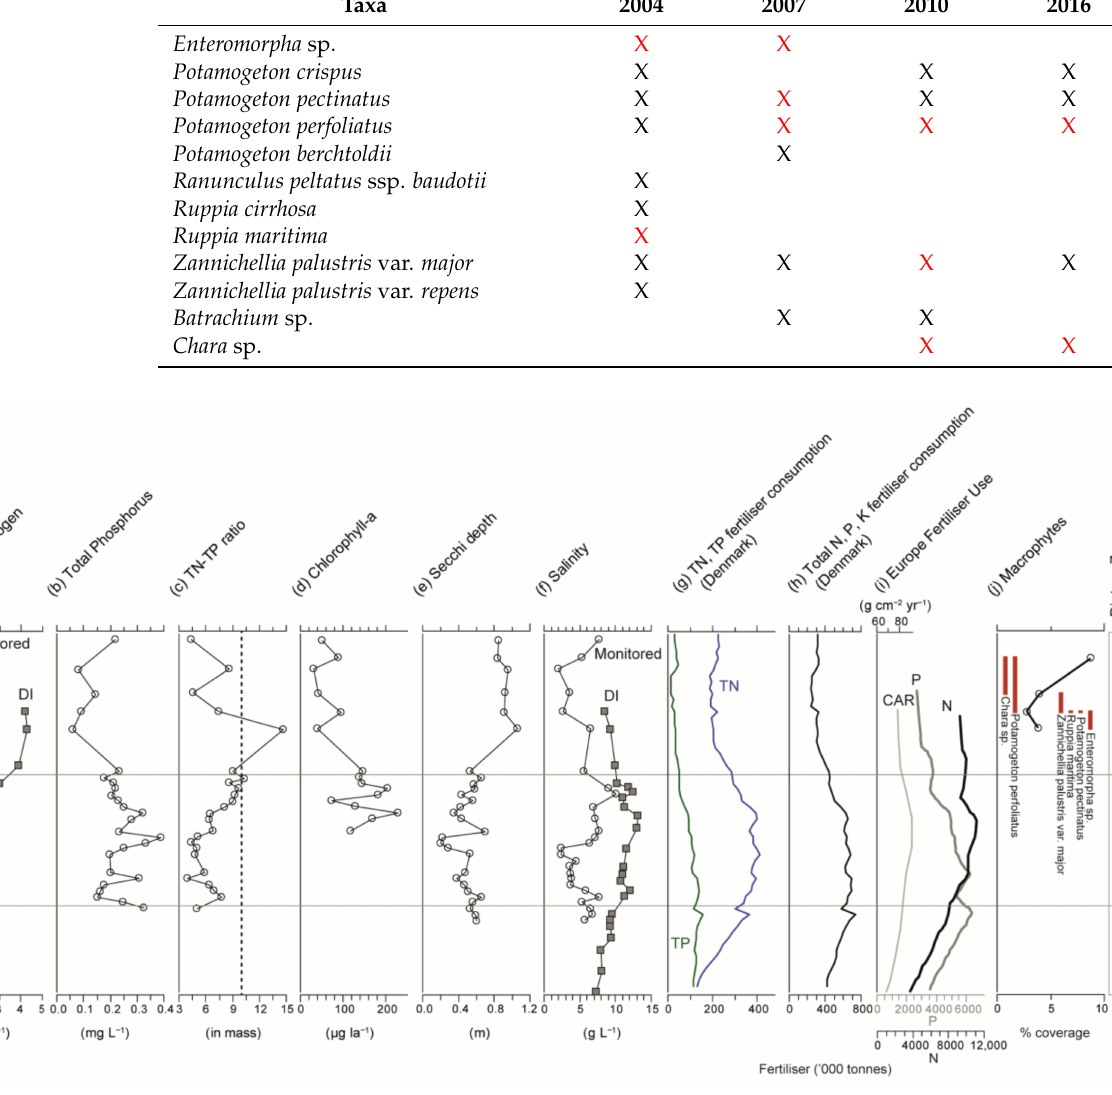
Figure 6. Summer means for Lake Kilen for the period 1976–2019 of ( a ) total nitrogen (TN); ( b ) total phosphorus (TP); ( c ) TN:TP ratio (as mass); ( d ) concentration of chlorophyll-a; ( e ) Secchi depth; ( f ) mean summer salinity in the surface waters. For TN ( a ) and salinity ( f ), diatom-inferred inferences (DI) are also plotted for comparison (also see Figure 4). ( g ) Total nitrogen and phosphorus fertilizer consumption in Denmark; ( h ) total NPK fertiliser consumption for Denmark (original source: www. ifastat.org/databases/plant-nutrition (accessed on 25 February 2023)); ( i ) Total European (EU-15) P and N fertiliser use and carbon accumulation rate (CAR) data for European lakes in the eutrophic- hypertrophic category (loess smooth; n = 55) after [65]; ( j ) Summary of macrophyte survey data for Kilen (based on data for dominant macrophytes in Table 2 and percentage macrophyte coverage in Figure